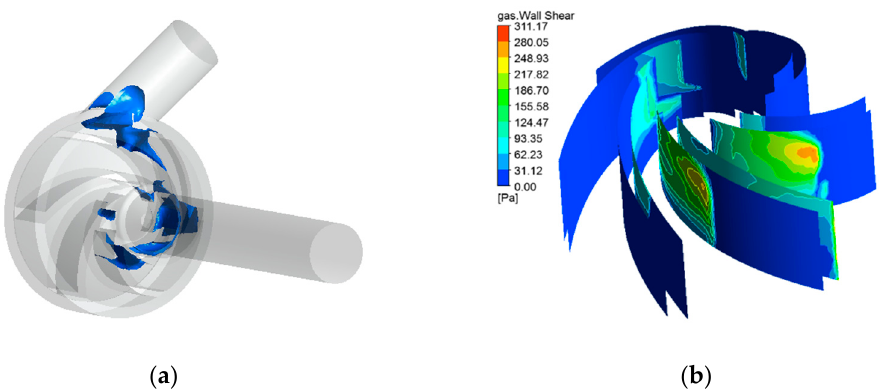
Figure 15. Results of ejection phase calculation: ( a ) cavitation bubble distribution; ( b ) wall shear stress